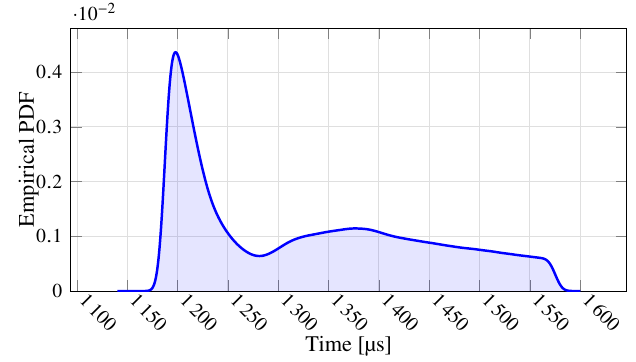
Figure 5. Empirical Probability Density Function of the Polling